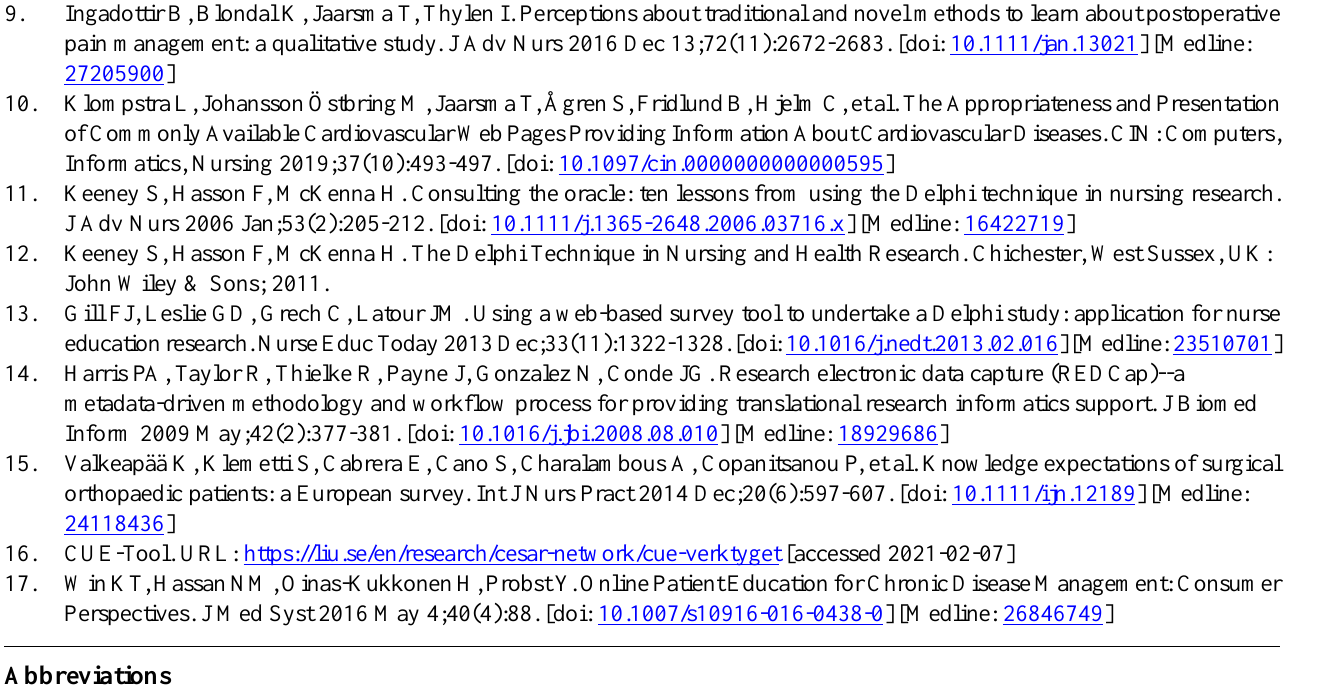
CESAR: Collaboration and Exchange in Swedish cardiovascular caring Academic Research CUE-tool: The Credible and Usable Evaluation of patient education tool for